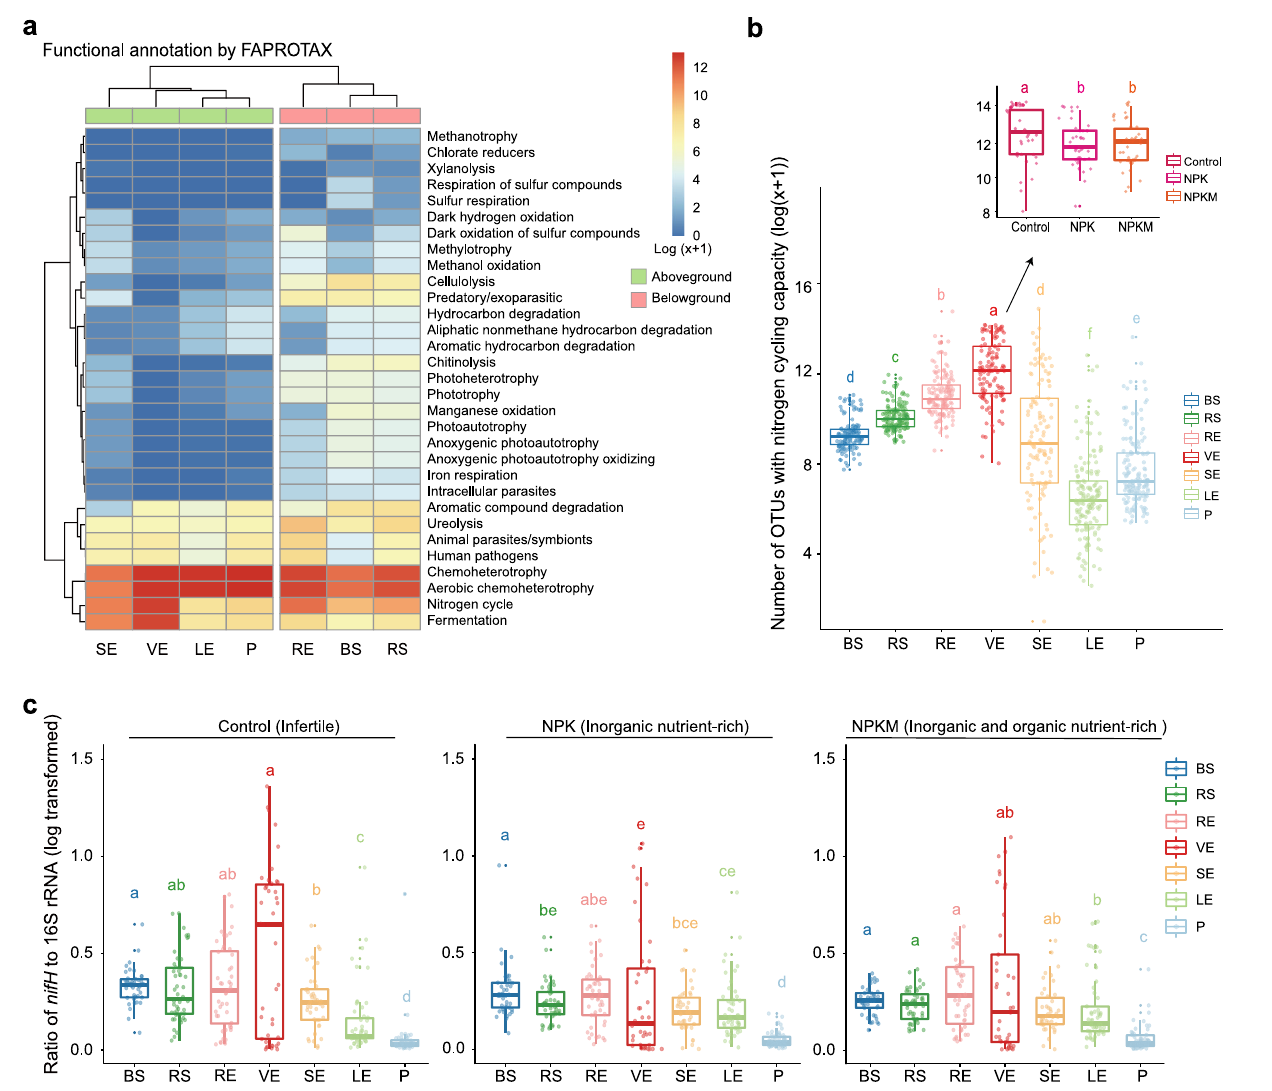
Fig. 3 Functional characteristics of xylem-inhabiting bacterial communities. a Heatmap of metabolic and ecological functions of bacteria based on FAPROTAX prediction. Data are based on OTUs occurrence (number of OTUs capable of each function) in soil and plant compartments (log(x + 1) transformed). b Number of OTUs capable of nitrogen cycling in soil and plant compartments based on FAPROTAX prediction. Boxplot on the upper right shows the number of OTUs capable of nitrogen cycling in fertilisation treatments. The sample sizes are as follows: BS, 126; RS, 141; RE, 138; VE, 119; SE, 120; LE, 158; P, 152; Control, 38; NPK, 38; NPKM, 42. c Ratio of nifH gene to 16 S rRNA in each compartment under fertilisation treatments, re fl ecting the relative N- fi xation potential of bacterial communities. The sample sizes are as follows, Control: BS, 41; RS, 48; RE, 48; VE, 39; SE, 42; LE, 52; P, 50; NPK: BS, 42; RS, 48; RE, 48; VE, 38; SE, 41; LE, 48; P, 52; NPKM: BS, 41; RS, 48; RE, 47; VE, 41; SE, 41; LE, 53; P, 54. Boxplot ( b and c ) displays the median and interquartile range. Upper and lower whiskers extend to data no more than 1.5× the interquartile range from the upper and lower edge of the box, respectively. Letters indicate statistical signi fi cance among groups using two-sided Wilcoxon test (adjusted P < 0.05 by Benjamini and Hochberg method). Source data and exact P values are provided in the Source Data fi